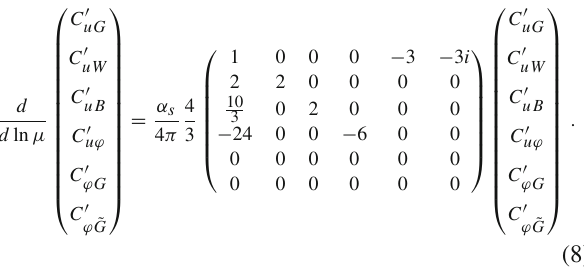
Fig. 2 Illustration of the energy scales and effective theories. At the high energy scale Λ , the UV theory is matched onto SMEFT. For measurements of the top quark, the dimension-six Wilson coefficients in L SMEFT are evolved to the scale μ t ∼ m t using the SMEFT RGE. For comparison with measurements of B physics, SMEFT is matched at a scale μ W ∼ m W onto WET. For measurements at the scale μ b ∼ m b , the coefficients in L WET are evolved using the WET RGE